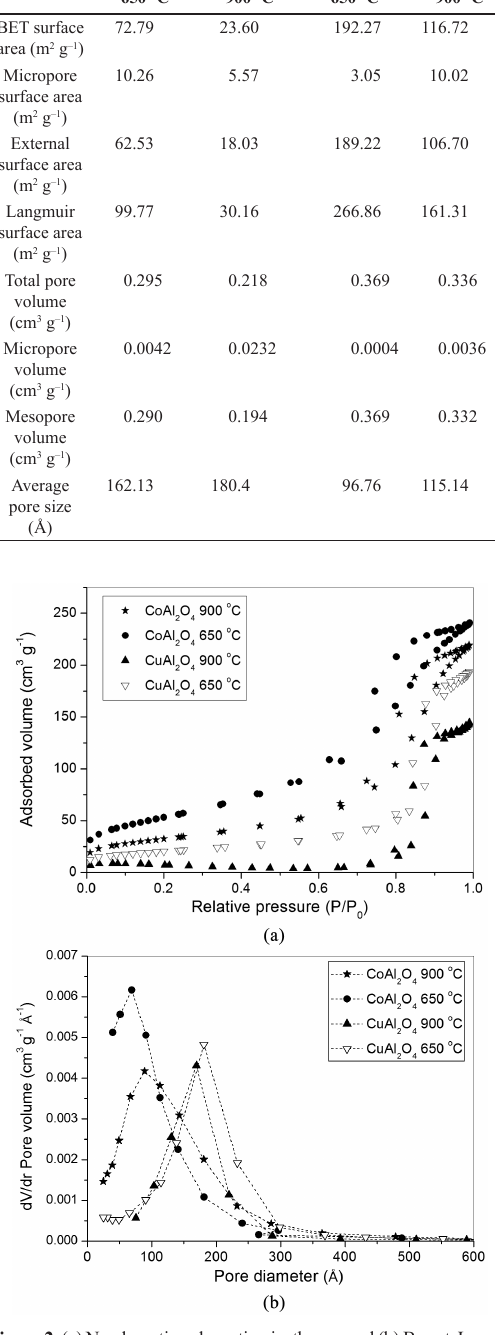
O reference 2 4 O Figure 2. (a) N adsorption-desoption isotherms and (b) Barret-Joyner- 2 4 2 Halenda (BJH) pore size distributions plots of different samples.